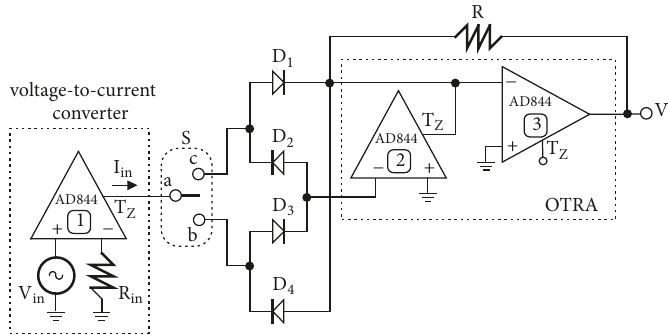
Figure 12: Complete hardware implementation of the circuit (Figure 3) for conducting the experiments.